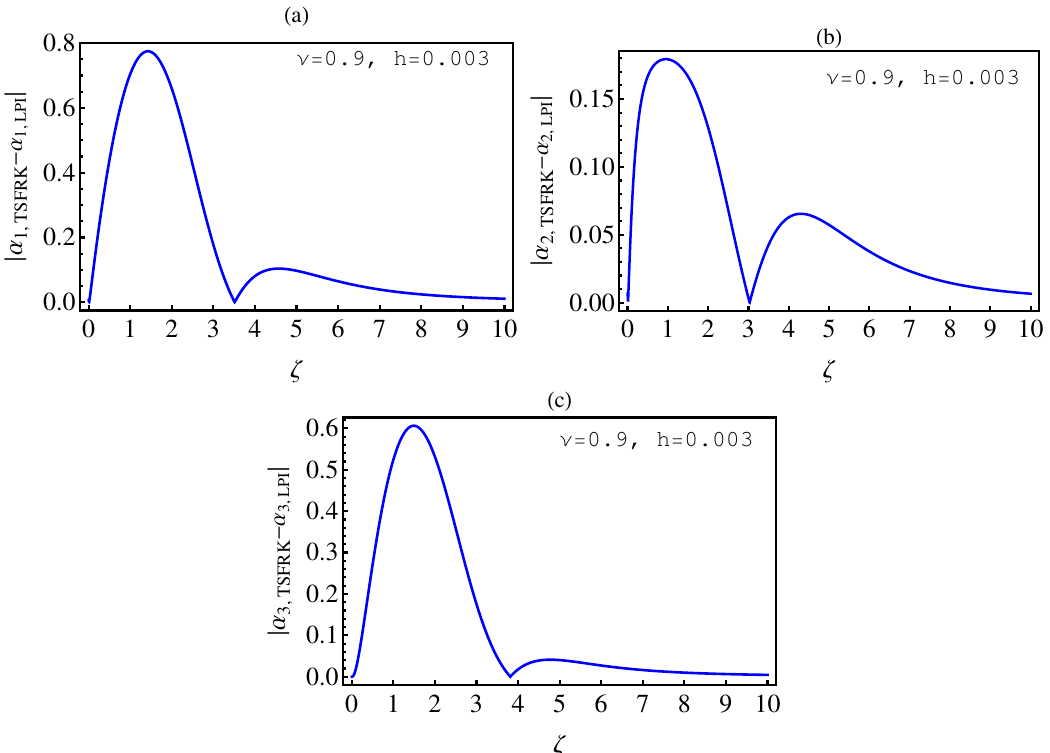
Figure 7. The absolute error between the numerical solutions of (2) to (4) based upon the LPI and the TSFRK for ν = 0.9, h = 0.03, m = 21, λ = 2, (cid:101) = 1, µ = 2, δ = 1 and for the initial values α 1 ( 0 ) = 0, α 2 ( 0 ) = 1 and α 3 ( 0 ) = λ (( a ), ( b ) and ( c ),